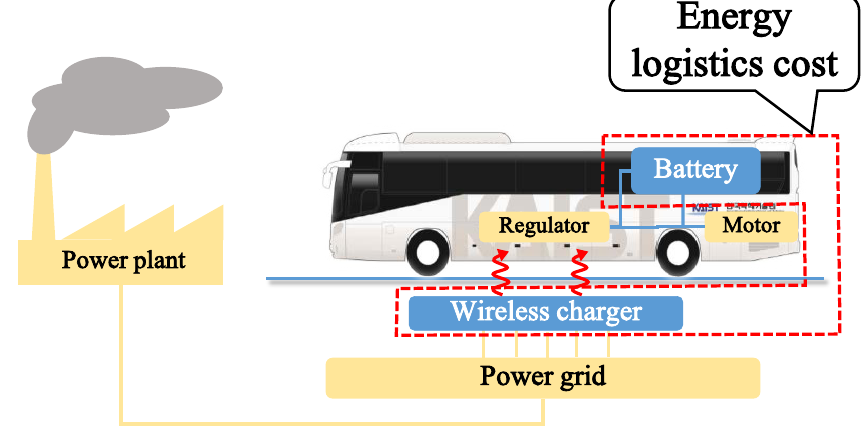
Figure 6. System boundary of the